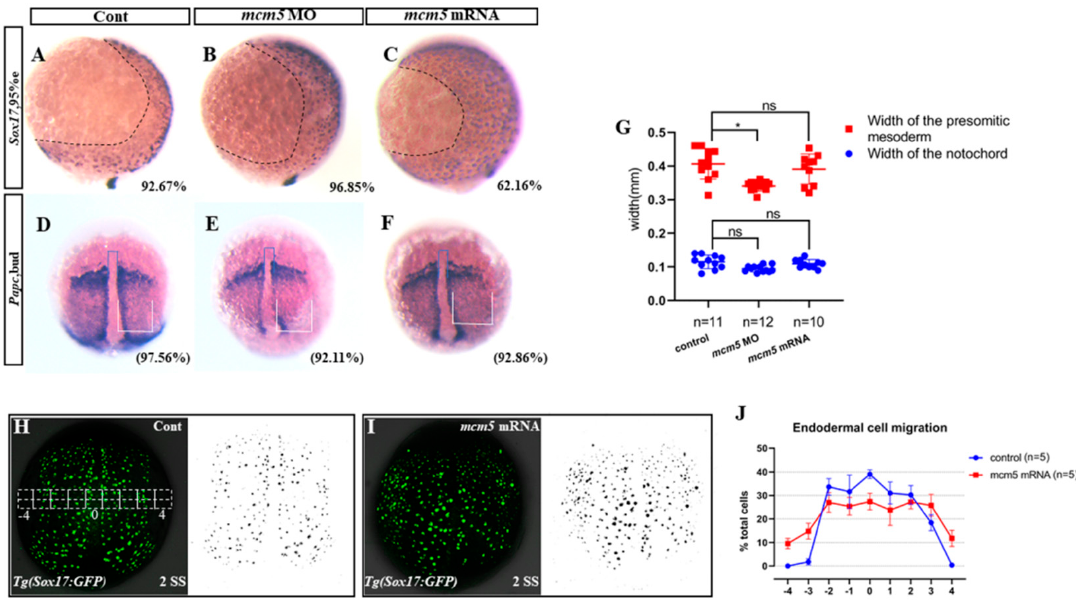
Figure 2. A forced expression of mcm5 depressed endodermal migration. ( A – C ) Compared with that in the control ( A , n = 109), the migration of endodermal cells in mcm5 morphants was normal ( B , n = 127), but the endodermal migration in embryos injected with mcm5 mRNA was slowed down ( C , n = 111, p = 0.0014). ( D – G ). Papc staining showed no difference in the width of the notochord (blue frame shown) between the control ( D , n = 41; G , n = 11) and embryos injected with mcm5 mRNA (E, n = 38; G , n = 10, p = 0.3), but the width of the notochord was mildly decreased in mcm5 morphants (E, n = 38; G , n = 12, p = 0.015). The width of the presomitic mesoderm (white frame shown) in mcm5 morphants was also mildly decreased ( E , n = 38; G , n = 12, p = 0.12), but it was normal in